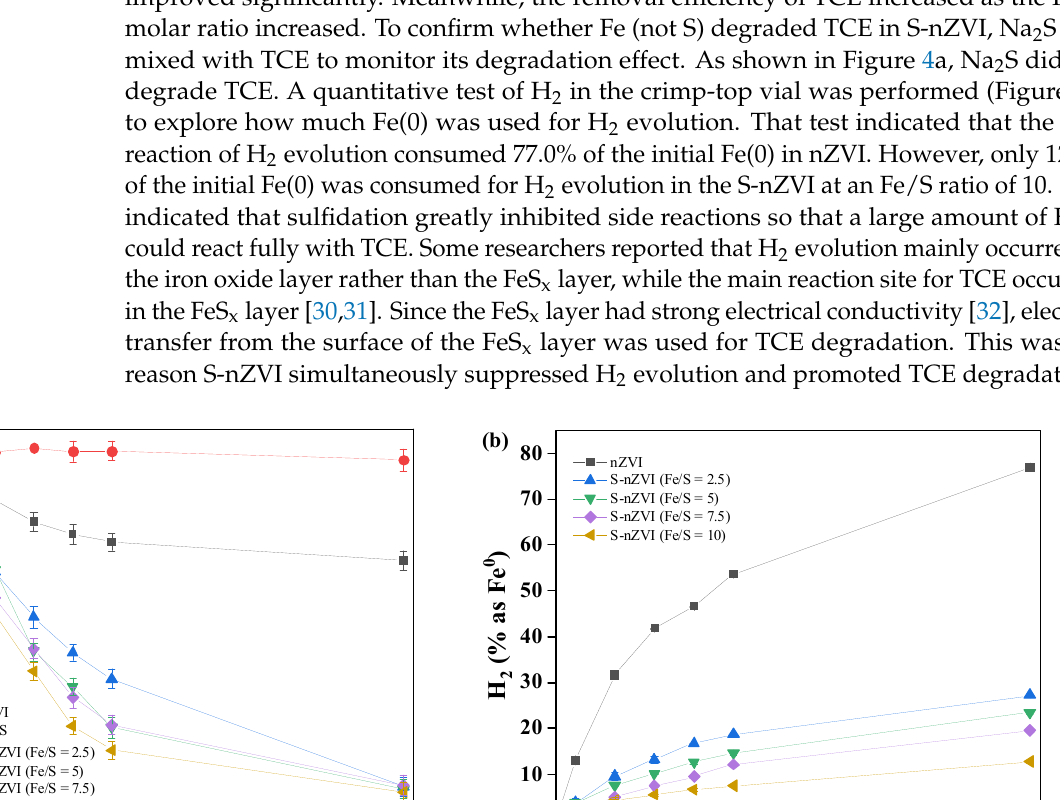
Figure 5. Reaction rates of TCE degradation by nZVI and S-nZVI materials with different Fe/S molar ratios. (pH: 7, t: 30 °C; nZVI and S-nZVI: 0.026 g, TCE: 10 ppm).